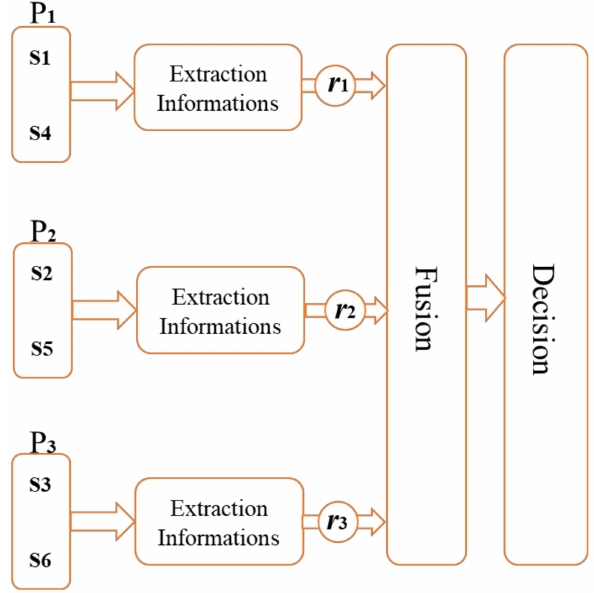
Figure 7. Representation of the proposer procedure method for transforming the fem signal measured by the sensors S1 and S2 in probability information about presence of a short-circuit fault in the machine.